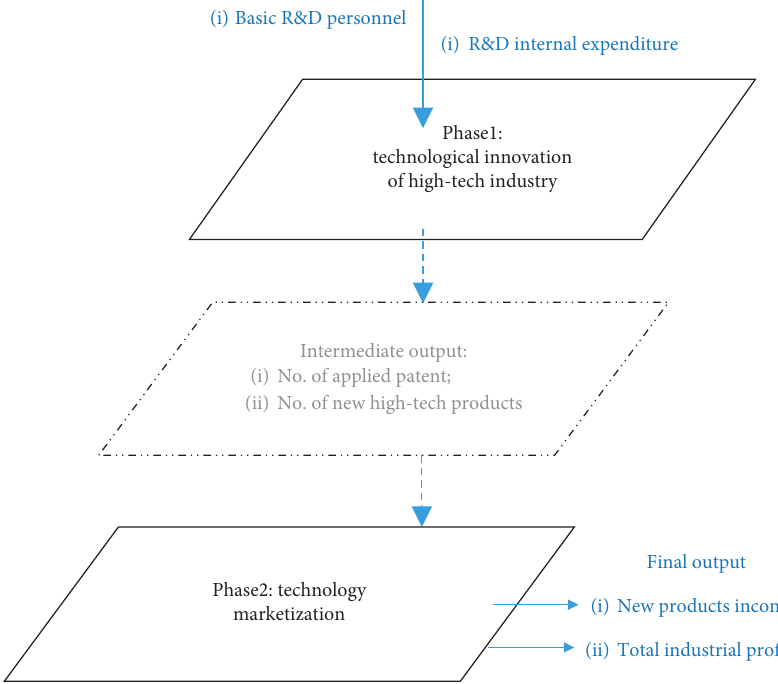
Figure 2: Conceptual model of technological innovation of the high-tech industry. Table.1: Indicator of high-tech innovation